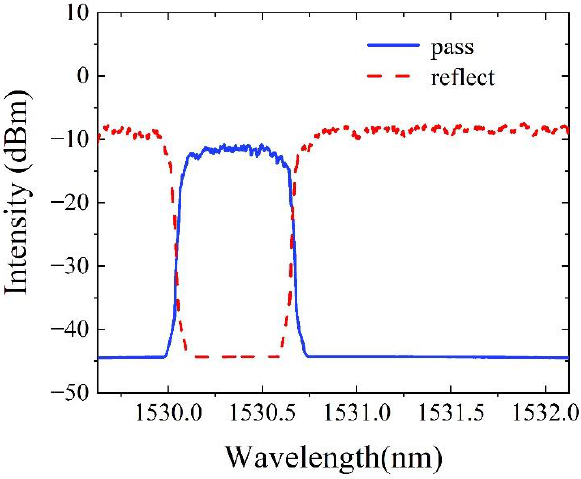
Figure 4. The working principle of the DWDM in the experiment.